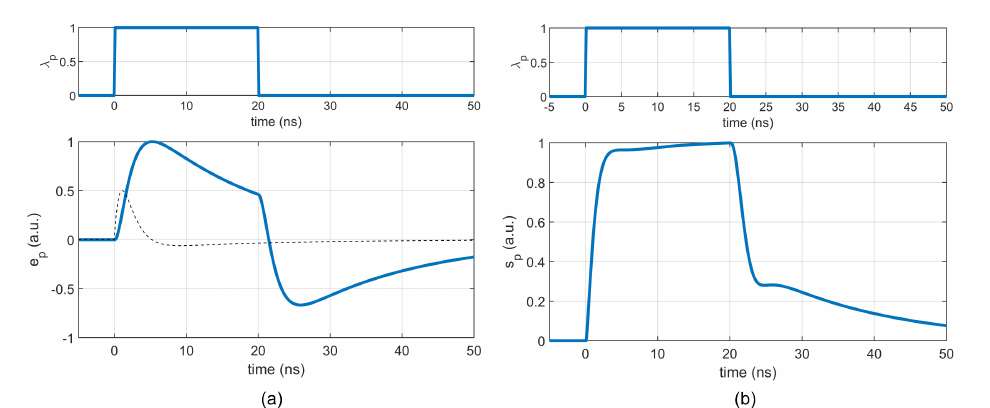
Figure 8. Mean and standard deviation of v ( t ) for T w = 20 ns, and Λ 0 = 1: ( a ) Normalized mean e p ( t ) computed using (21). The dashed line shows a single pulse of v p 2 for comparison. ( b ) Normalized standard deviation s p ( t ) computed using (22).